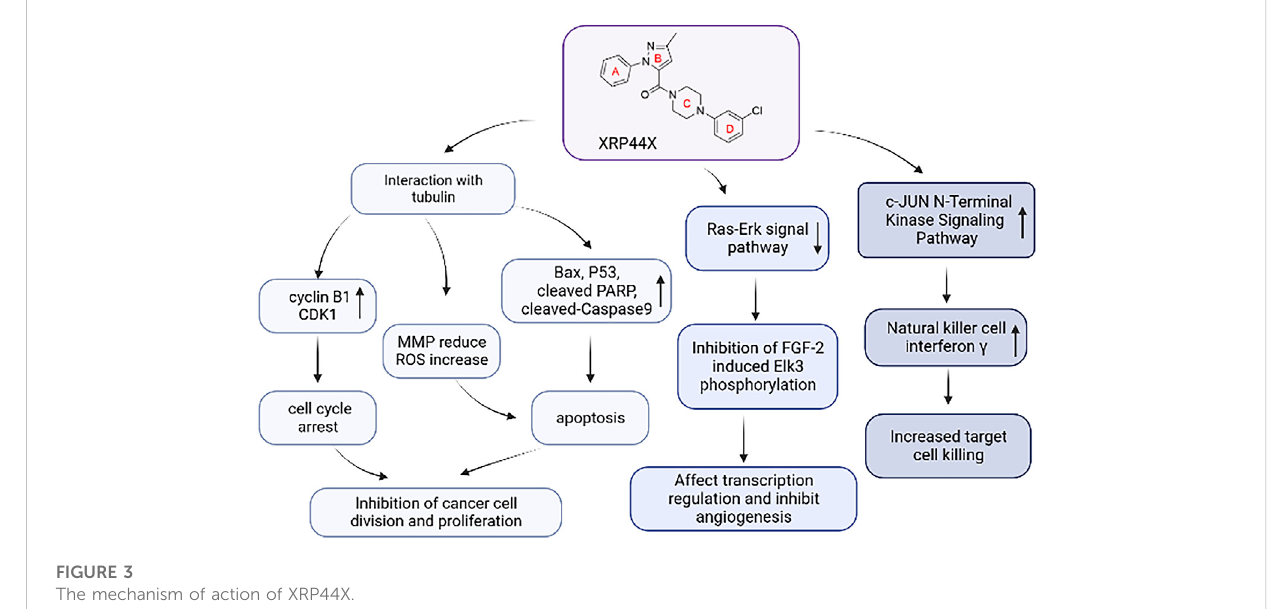
FIGURE 3 The mechanism of action of XRP44X.